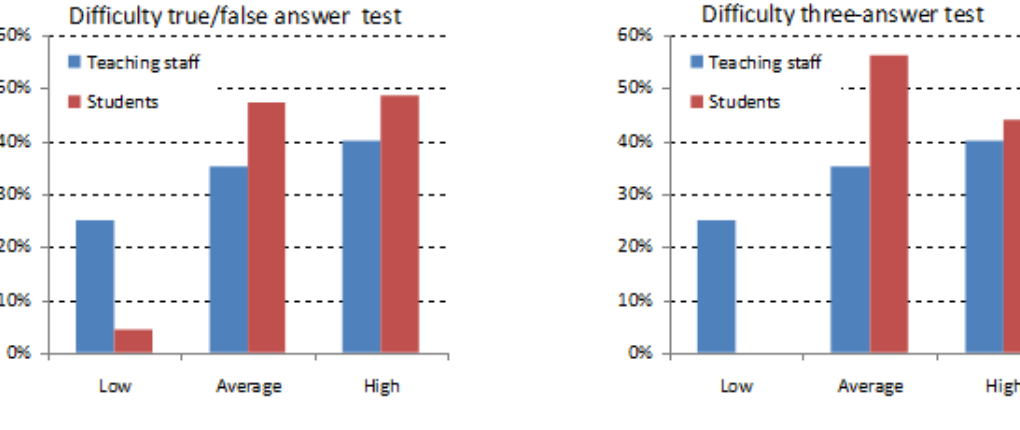
Figure 6. Difficulty level of the questions